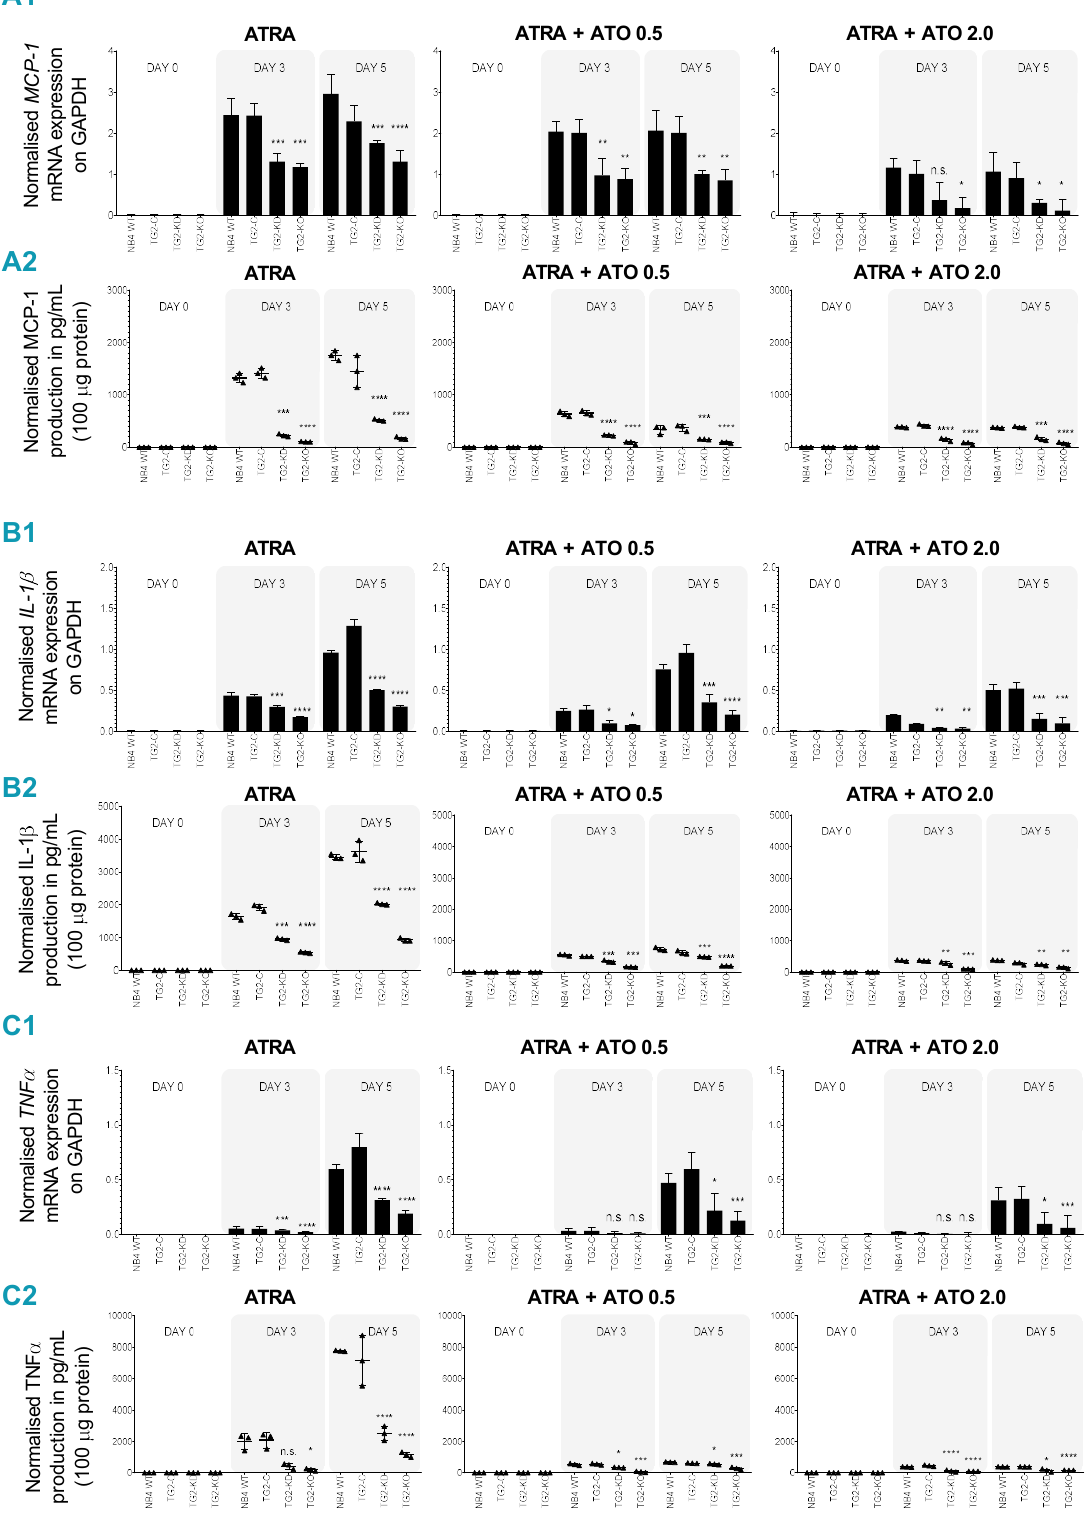
Figure 3. Combined ATRA + ATO treatment can reduce the MCP-1, IL-1 β and TNF α inflammatory biomarkers. ( A1,B1,C1 ) NB4 WT, TG2-C, TG2-KD and TG2-KO cells were incubated with 1 µ M ATRA (left panel), ATO (0.5 µ M or 2.0 µ M) and a combination of the two (middle and right panels) for three and for five days. Relative mRNA expressions of MCP-1 ( A1 ), IL-1 β ( B1 ) and TNF α ( C1 ) were